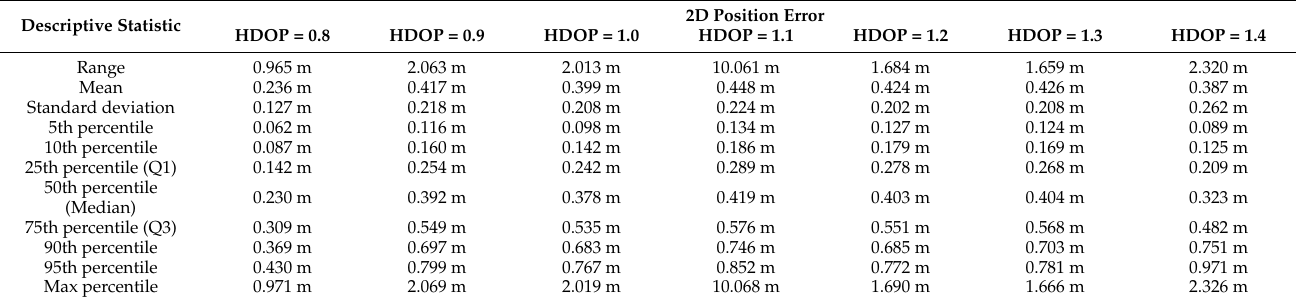
Table 2. 2D position error statistics for different HDOP values in the DGPS system. Descriptive